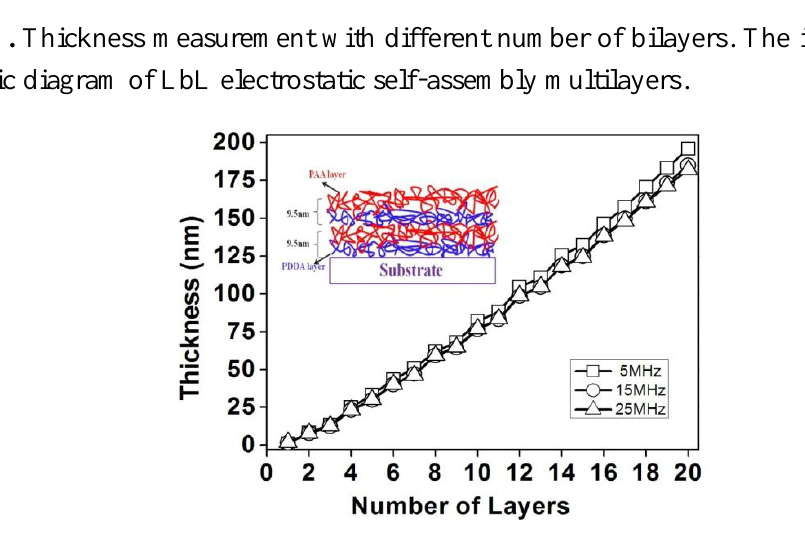
Figure 2. AFM images of multilayer nanocoatings ( a ) (PDDA/PAA)